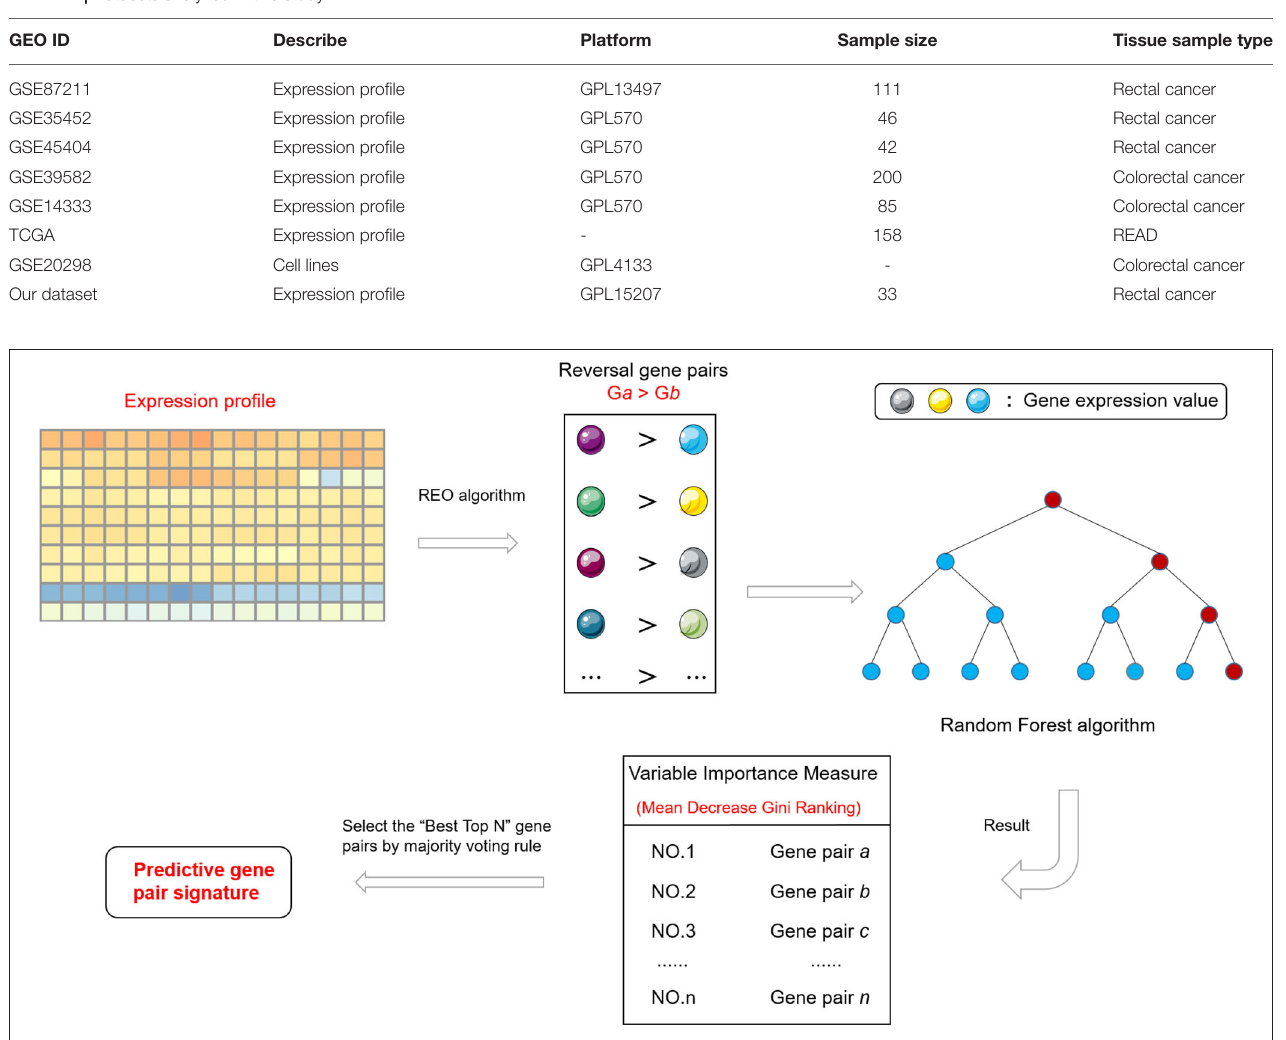
FIGURE 1 | Flowchart of signature discovery process and validation in this